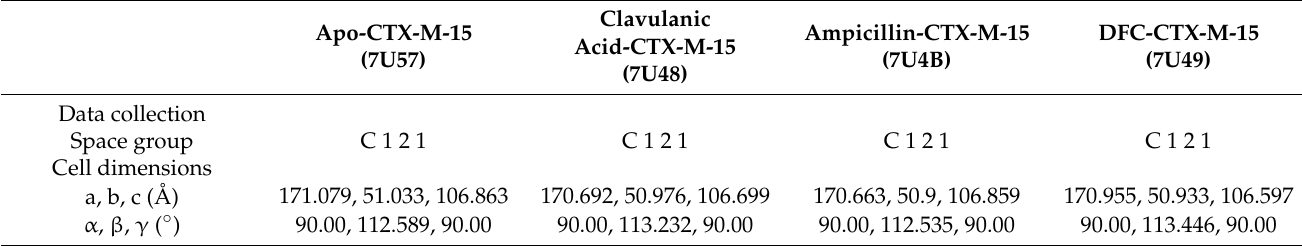
Table 1. Data collection and refinement